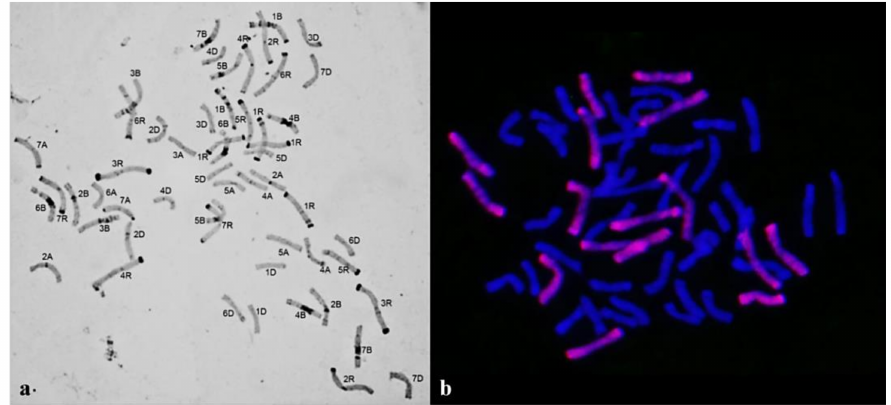
Figure 12. Chromosome sets of plants of Group 3: ( a ) Chromosome number 2 n = 53, 1R(1A) substitution, and monosomic substitutions 3R(3A) and 6R(6A), C-banding; ( b ) 2 n = 56, 40W+16R; GISH. Rye chromosomes are labeled red.